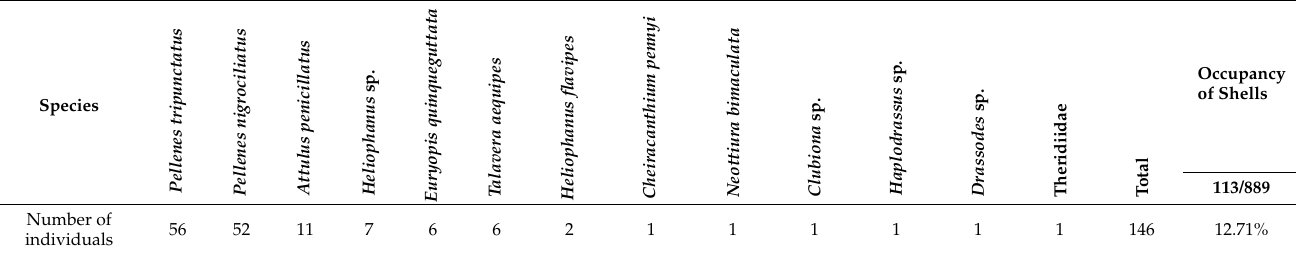
Table 2. Species diversity identified in empty shells of